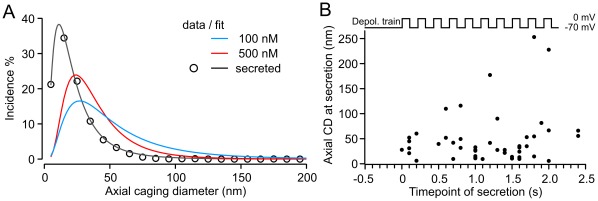
Axial mobility of secreted vesicles was reduced to a minimum immediately before fusion.(A) Histogram of the averaged axial CD distribution of secreted vesicles from cells at a pre-stimulus [Ca2+]i of 590 nM (black). Data points are represented by circles, and the solid line represents the log-normal fit. The CD values were calculated from the last 15 s prior to fusion induced by a train of depolarizations. The two fits obtained from resting cells kept at 100 nM (blue) and 500 nM (red) [Ca2+]i were plotted for comparison. N100nM/n: 23/719; N500nM/n: 26/695; Nsecreted/n: 19/53. Note the large left shift of the histogram of axial CDs measured from secreted LDCVs compared to the histograms of cells at rest. (B) Mobility of LDCVs during the last second prior to secretion. The stimulation protocol is shown on top.